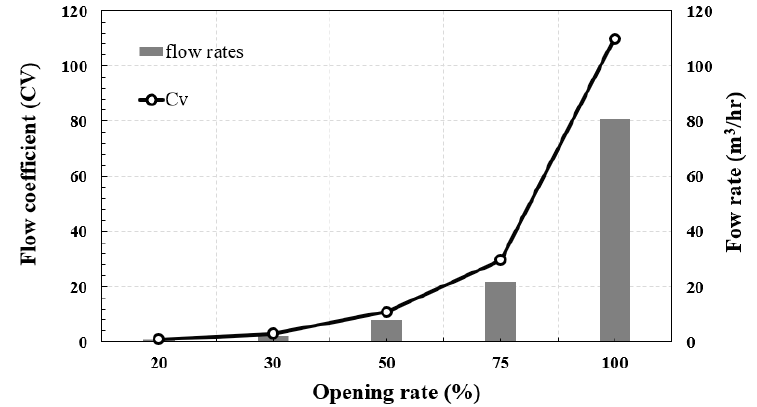
Figure 4. Streamlines at an opening rate of 20% for the cylinder-in-ball valve. Figure 5. CV and Q values due to changes in the opening rate. Figure 5. CV and Q values due to changes in the opening rate.